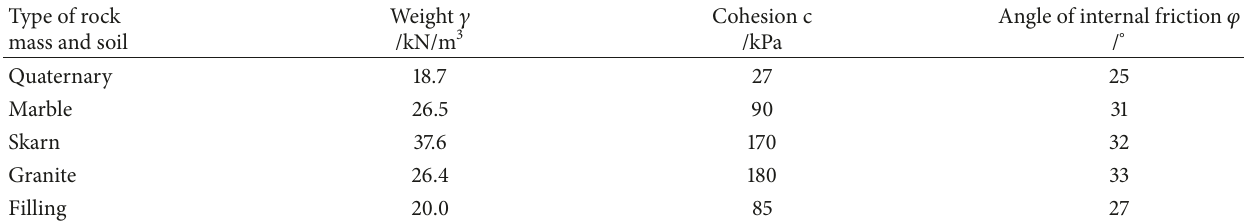
Figure 4: Evolution of the failure of a slope overlying a mined-out area. Table 2: Physical and mechanical parameters of rock mass and